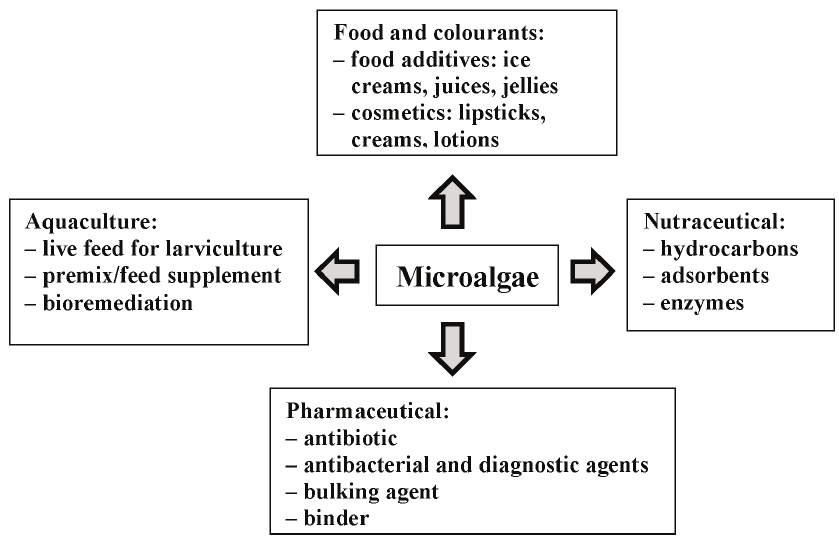
Fig. 3 – Commercial applications of microalgae in different fields (adapted from Begum et al. 74